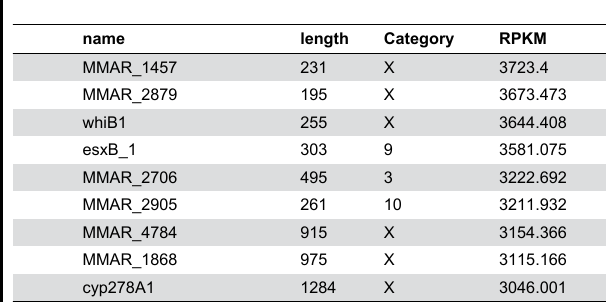
genes (Table S6). In early stationary phase, genes of “PE/PPE family” with significant changes were dominantly up regulated (116/121). Meantime, 262 genes belonging to “intermediary metabolism and respiration” changed at least 2-fold, among which 106 were up regulated and 156 were down regulated. For these genes with no homologues in Mtb , 1052 have significant changes between two samples and mostly (82.8%) were up regulated. Furthermore, 8 out of 9 genes were up regulated for the category of “insertion seqs and phage”. In contrast, when we refer to the category of “virulence, detoxification and adaptation”, more genes turn out to be down- regulated. Besides, genes encoding early secreted antigenic target of 6 kDa (ESAT-6) and culture filtrate protein of 10 (CFP-10) stayed unchanged between two samples, together with most of the key components forming ESX-1 secretion system (Table S7). Three genes ( MMAR_5439, MMAR_5368 and MMAR_1553 ) encoding proteins known to be secreted by ESX-1 were down regulated in early stationary culture [19,20]. In addition, genes constituting ESX-5 secretion system were generally up regulated in early stationary phase culture together with a gene known to encode ESX-5 dependent secreting protein MMAR-3728.